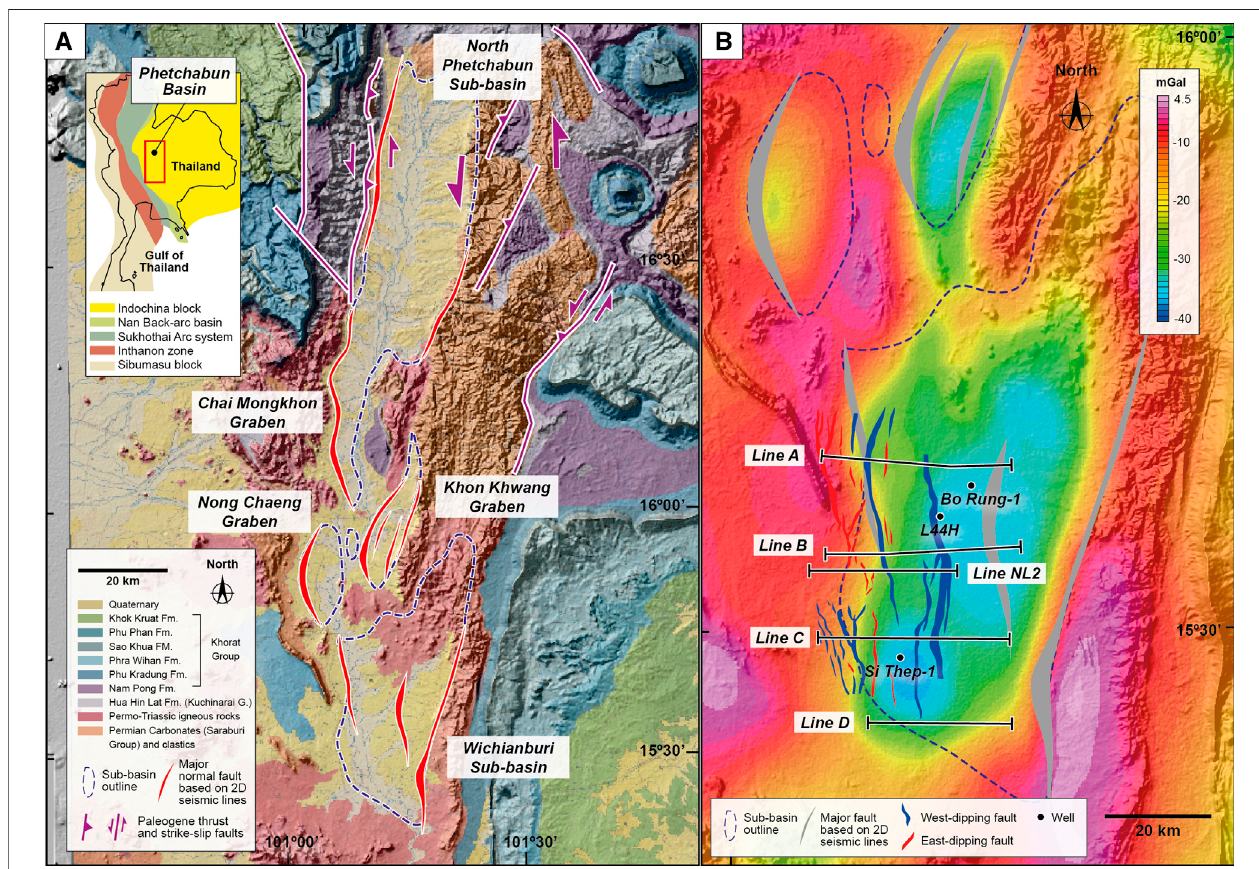
FIGURE 1 | (A) Geologic map showing the location of the Phetchabun Basin and the outline of its grabens and sub-basins. Major normal faults of the Phetchabun Basin interpreted by Remus et al. (1993) based on regional 2D seismic data are shown. These faults lie within the N-S trending Paleogene transpressional belt that caused uplift and erosion of the pre-Cenozoic rocks along the western margin of Indochina block (see inset). Thrust and strike-slip faults are from Morley (2012). (B) GravityanomalymapoftheWichianburiSub-basinillustratingthebasingeometry.Basementfaultmapfrom3DseismicinterpretationbyPongwapeeetal.(2019a) is overlaid with the locations of the Bo Rang-1, L44H, and Si Thep-1 wells. 2D seismic sections (Line A – Line D) are interpreted in this study.